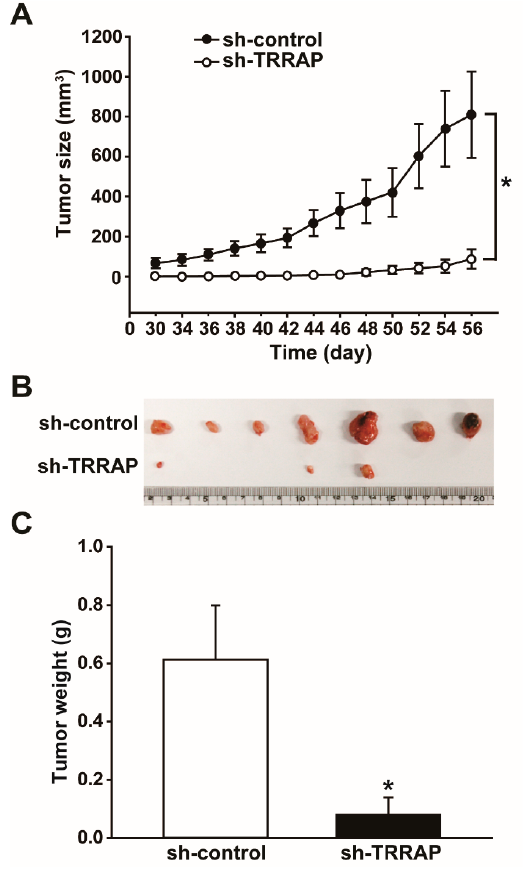
Figure 6. E ff ects of TRRAP silencing on the in vivo tumorigenic potential of HCT-15 spheroids. ( A ) E ff ects of TRRAP silencing on the in vivo growth of xenografts containing HCT-15 spheroids. HCT-15 spheroids were infected with lentiviruses expressing sh-control or sh-TRRAP and